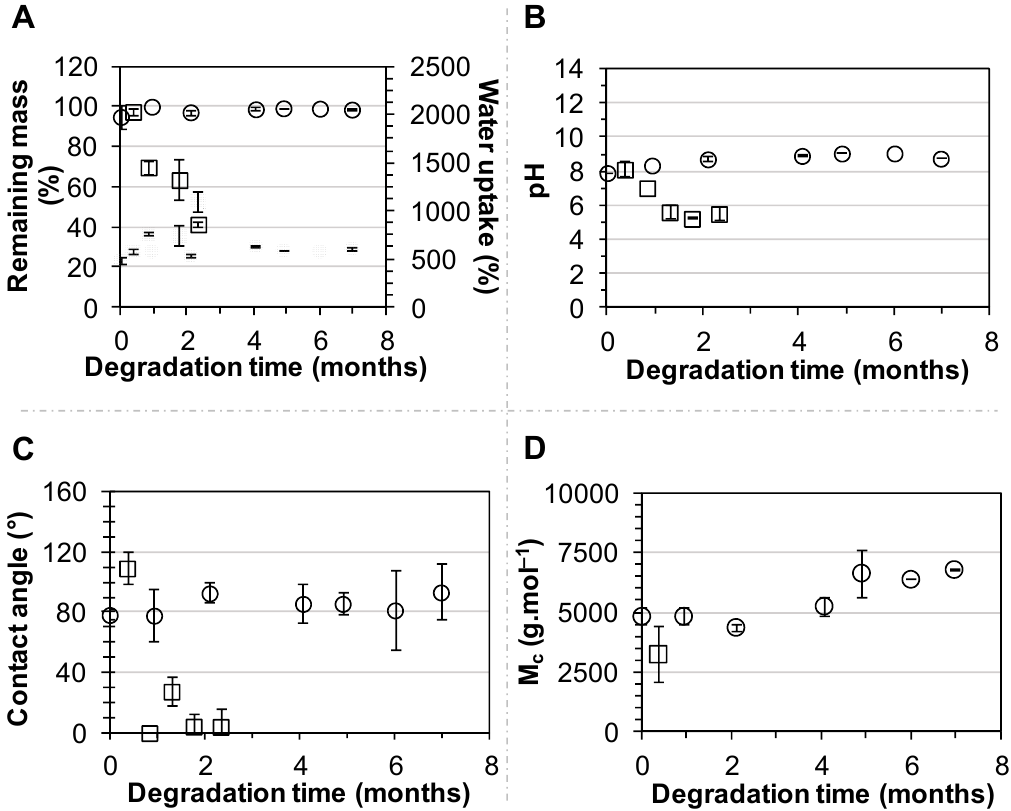
Figure 5. Incubation of PEUUF scaffolds in the degradation medium at 37 °C ( ) and 90 °C ( ) over a period of 7 months and 70 days, respectively: ( A ) Scaffold remaining mass (open symbols) and water uptake (full symbols); ( B ) Medium pH; ( C ) Water contact angle; ( D ) Scaffold number average molecular weight between cross-links M(cid:3365) (cid:2913) . (The LMW fucoidan concentration in the aqueous phase of the HIPE used for functionalization = 10 mg mL ‒ 1 ).